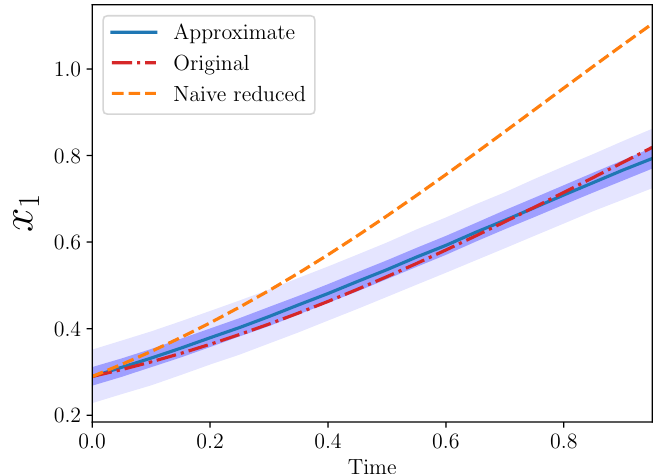
Figure 5. Approximate integral model for β = 3, α =